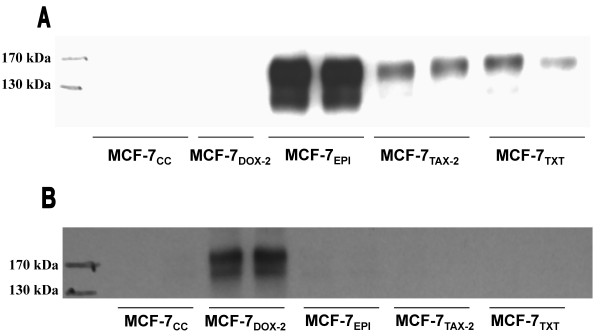
Levels of expression of the ABCB1 and ABCC1 drug transporters in MCF-7CC, MCF-7DOX-2, MCF-7EPI, MCF-7TAX-2 and MCF-7TXT cell lines at selection dose 12. The ABCB1 and ABCC1 drug transporters were immunoprecipitated from whole cell extracts using protein A/G sepharose and antibodies specific for ABCB1 (A) or ABCC1 (B). The level of expression of the drug transporters was then assessed in immunoblotting experiments using the same antibodies.